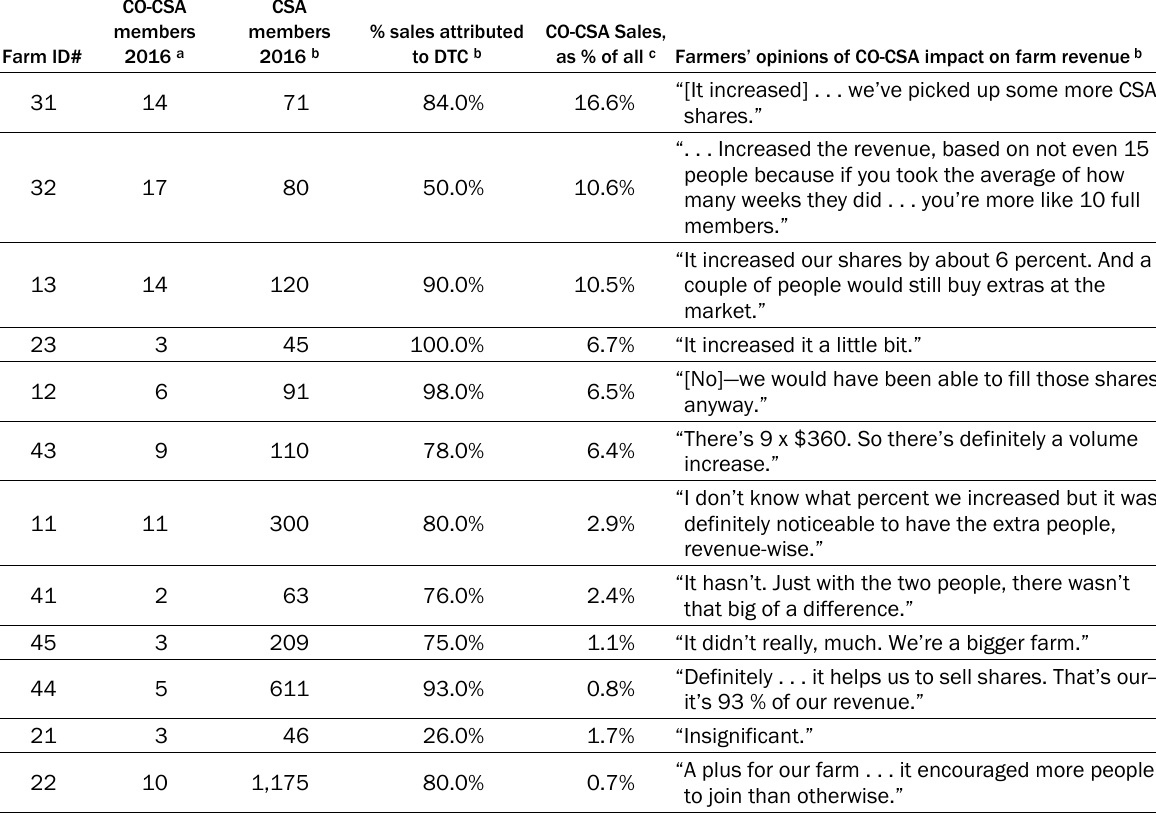
Table 2. Cost-offset Community Support Agriculture (CO-CSA) Sales and Perceived Impact on